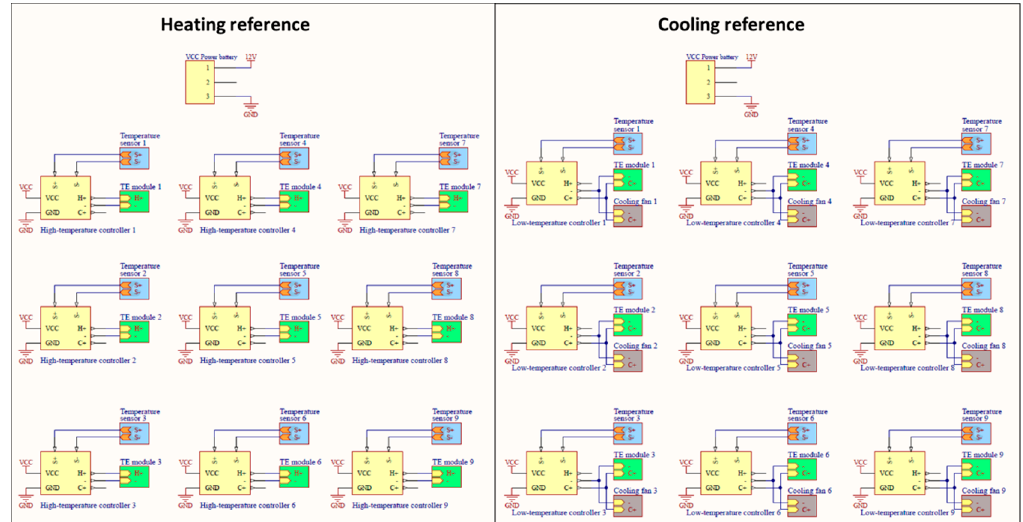
Figure 3. Schematic diagram of the circuit system of the temperature-controlled references.